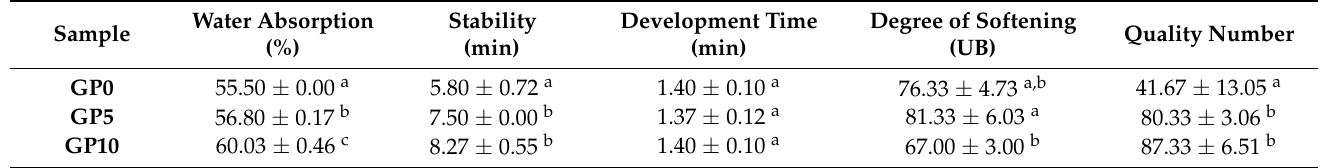
Table 1. Farinograph characteristics of dough supplemented with grape pomace powder.